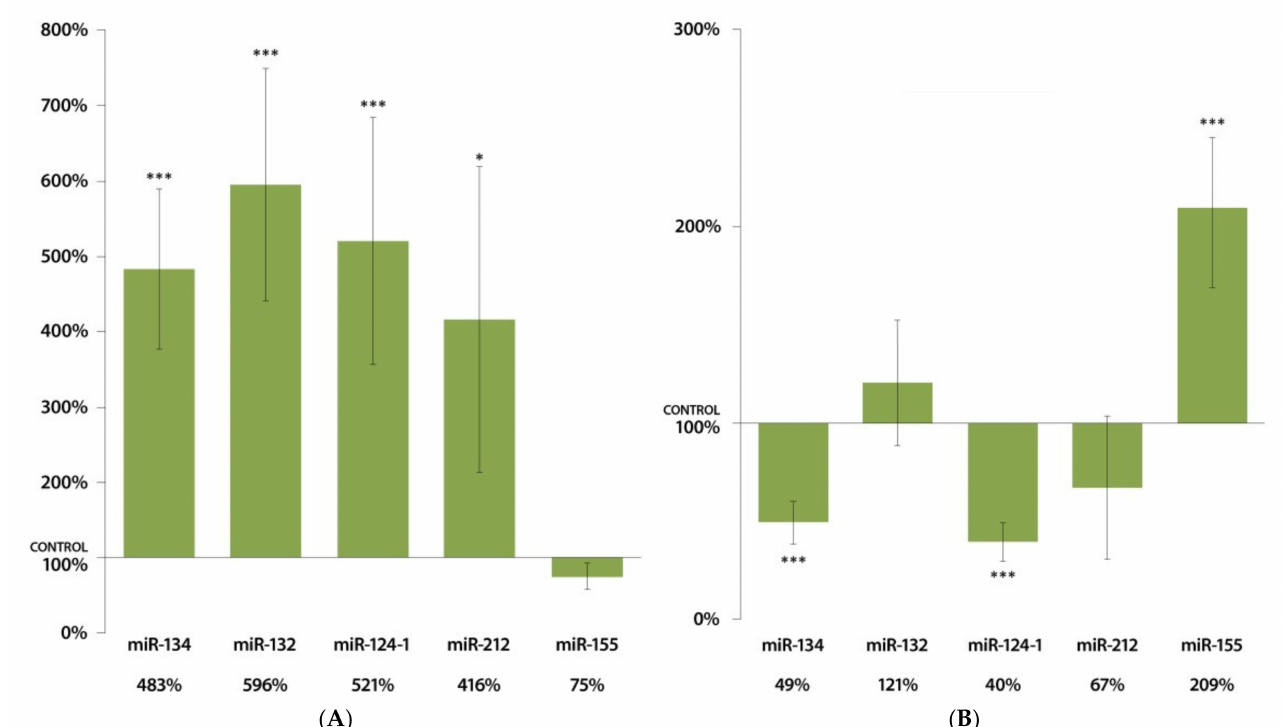
Figure 3. Expression results of miR-134, miR-132, miR-124-1, miR-212, and miR-155 in the kidneys of ( A ) female and ( B ) male CBA/Ca mice 24 h after DMBA treatment, compared to non-treated mice (100%) (* p < 0.05; *** p <